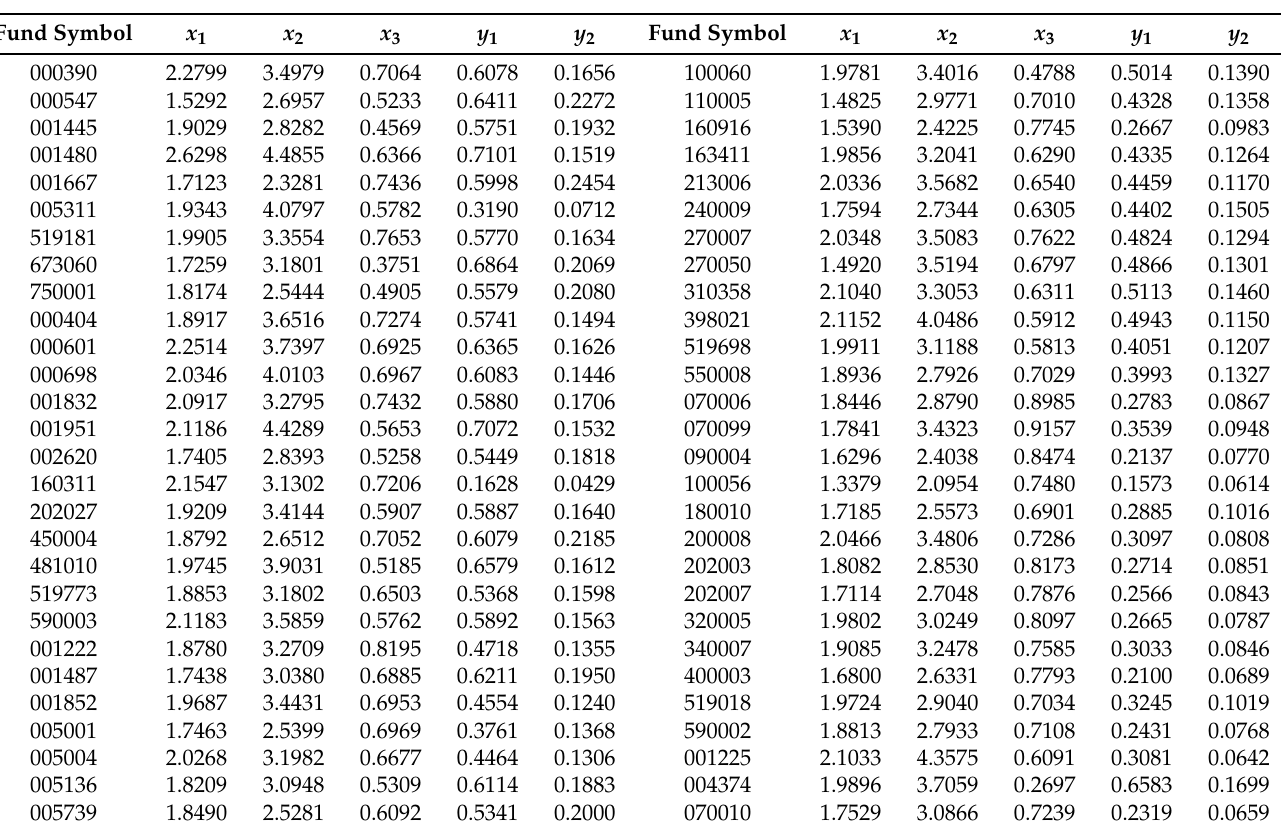
Table 6. Input and output data for fund performance